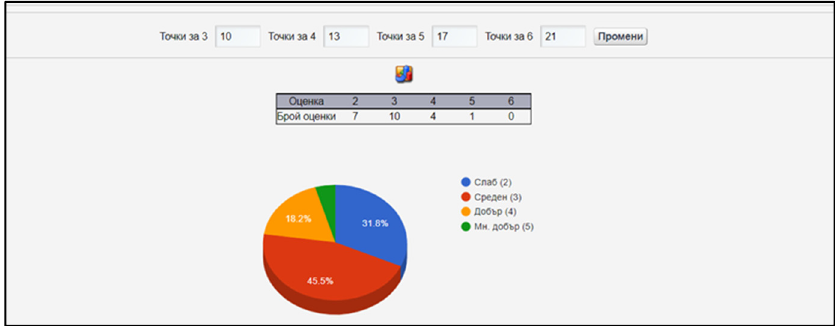
Figure 7. Protocol and statistics about the test results (in